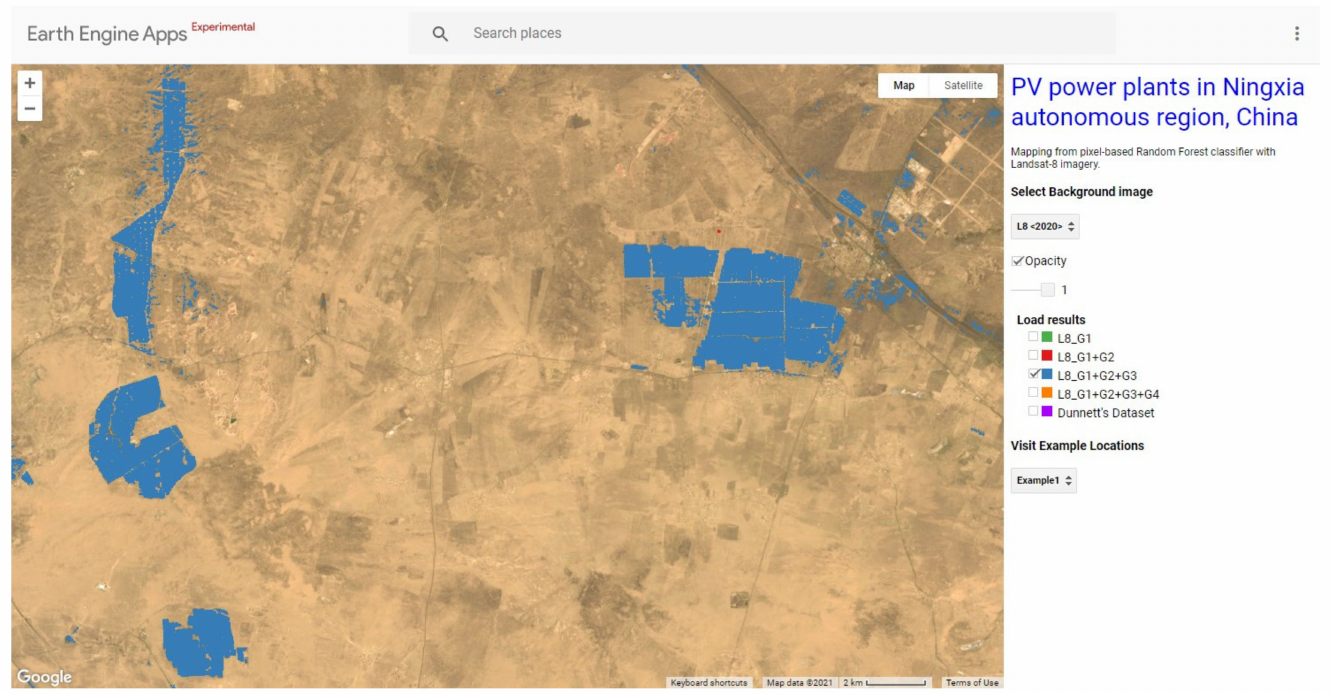
Figure 6. An example part of the classified map of PV power plants in Ningxia autonomous region, China, from a pixel- based RF model with different variable sets. The total detailed result is showed online with an app developed with the help of the Google Earth Engine platform. The App’s website is (https://xunhezhang.users.earthengine.app/view/ningxia-pv- power-plants (accessed on 29 September